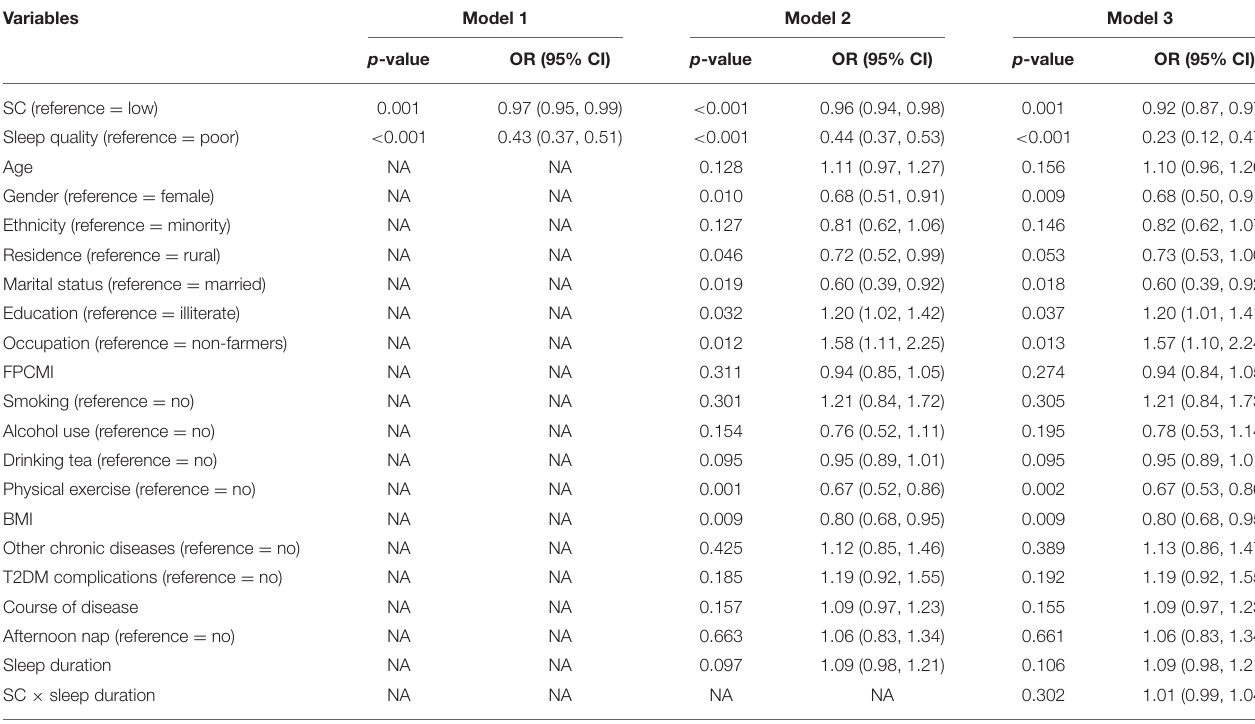
TABLE 3 | Logistic regression model for interaction between SC and sleep quality on depressive symptoms ( n = 1,761).